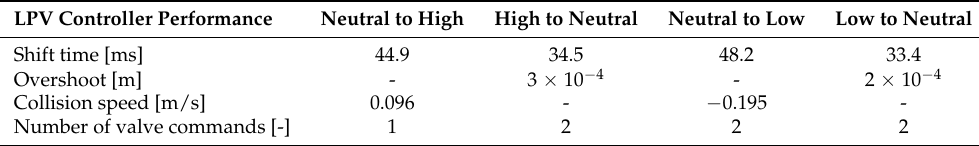
Table 1. Summary of the LPV controller performances (simulation).